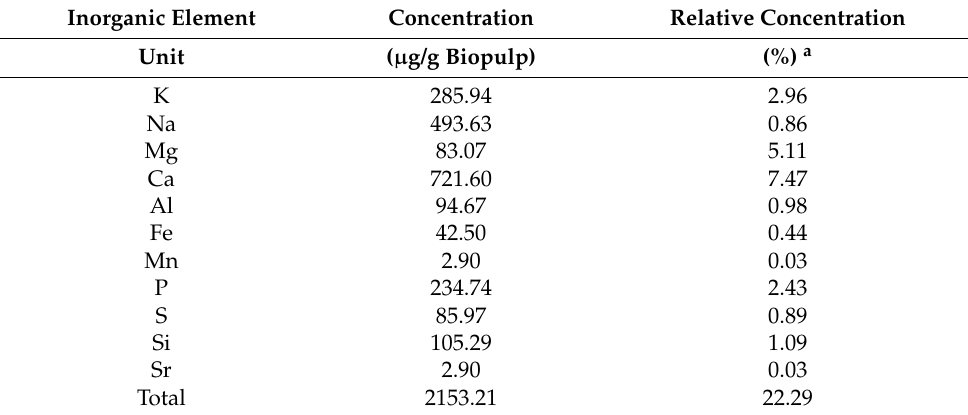
Table 2. Inorganic element distribution in the